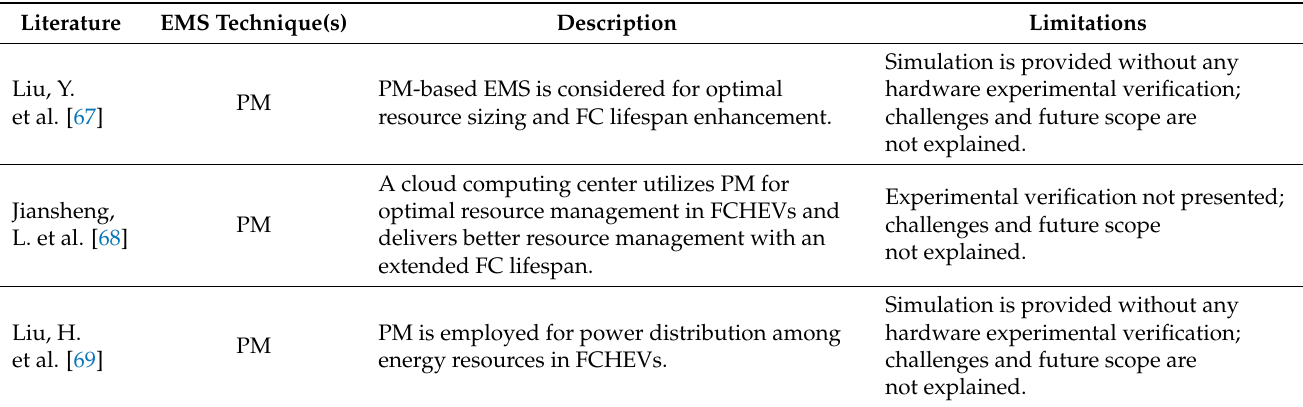
Table 7. Summary of the latest literature related to PM- and GT-based